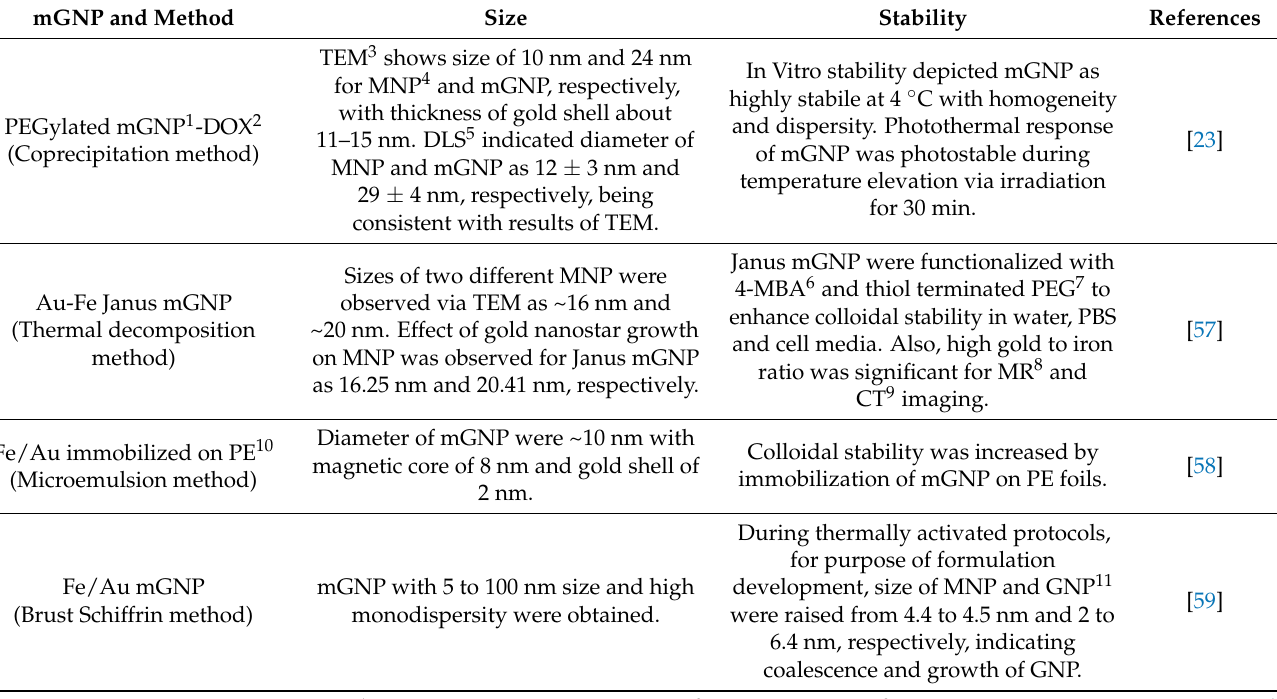
Table 1. Size and stability analysis of magnetic gold nanoparticles synthesized via various methods. mGNP and Method Size